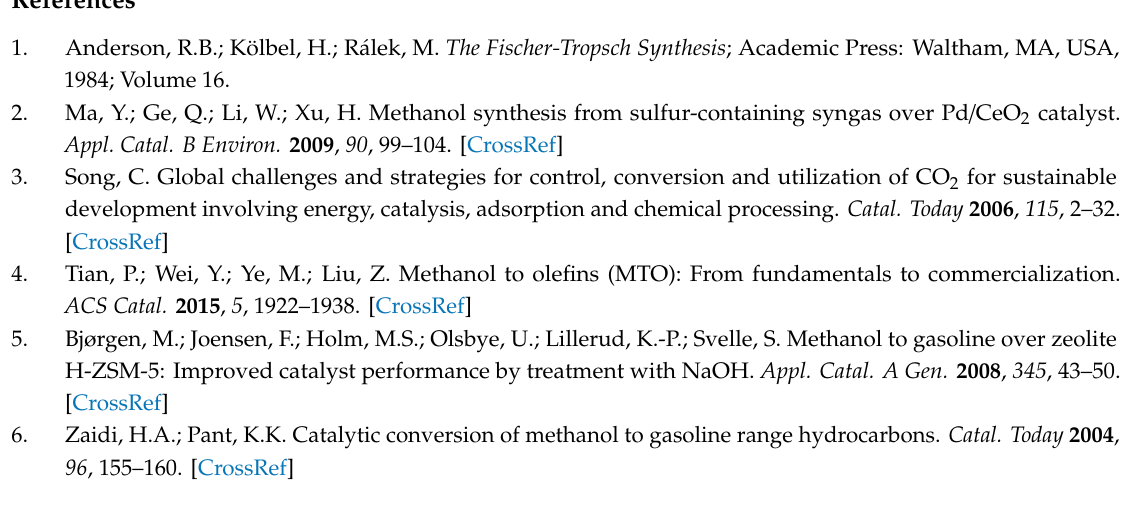
Table S1: List of chemical species appearing in methane thermochlorination kinetic scheme from ref. [14,15], Table S2: Microkinetic model of methane halogenation using iodine and bromine in the gas phase from ref